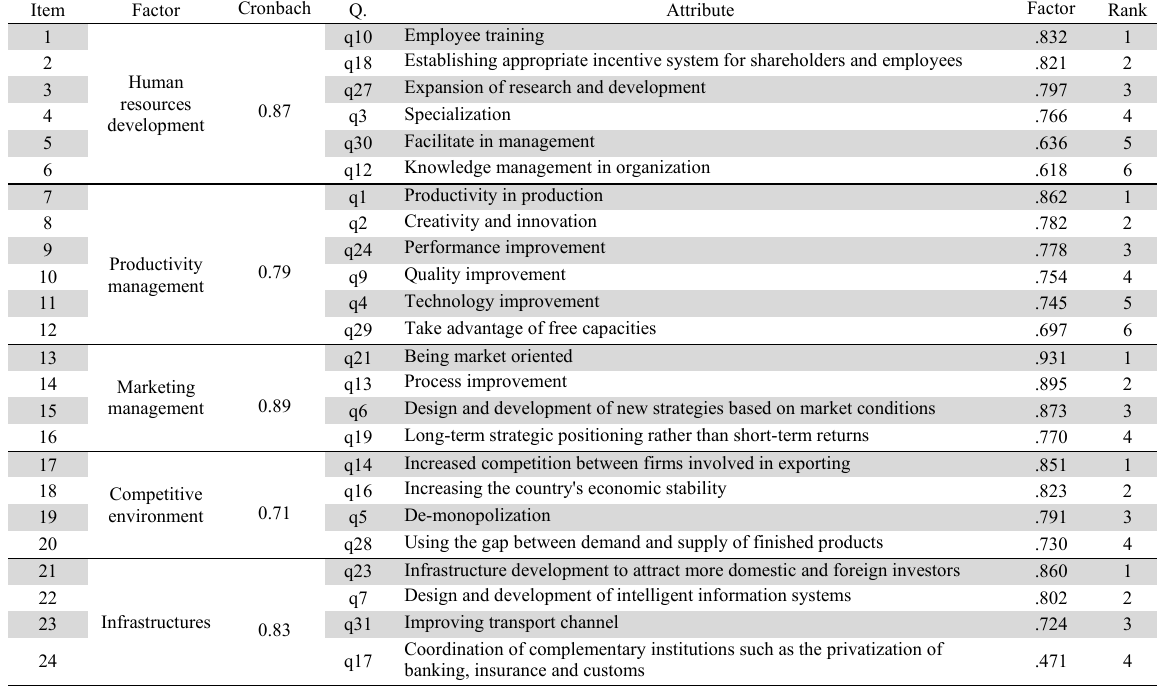
The results of principal component